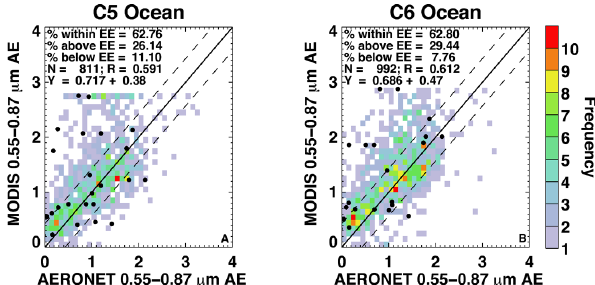
Fig. 17. Frequency scatter plots for AE at 0.55/0.86µm over DT- ocean compared to AERONET (gray and color dots) and MAN (black dots), plotted from 6 months of Aqua (January and July; 2003, 2008 and 2010), computed with C5 algorithm (a) and C6 al- gorithm (b) . One-one lines and EE envelopes ( ± 0.45) are plotted as solid and dashed lines. Collocation statistics are presented in each